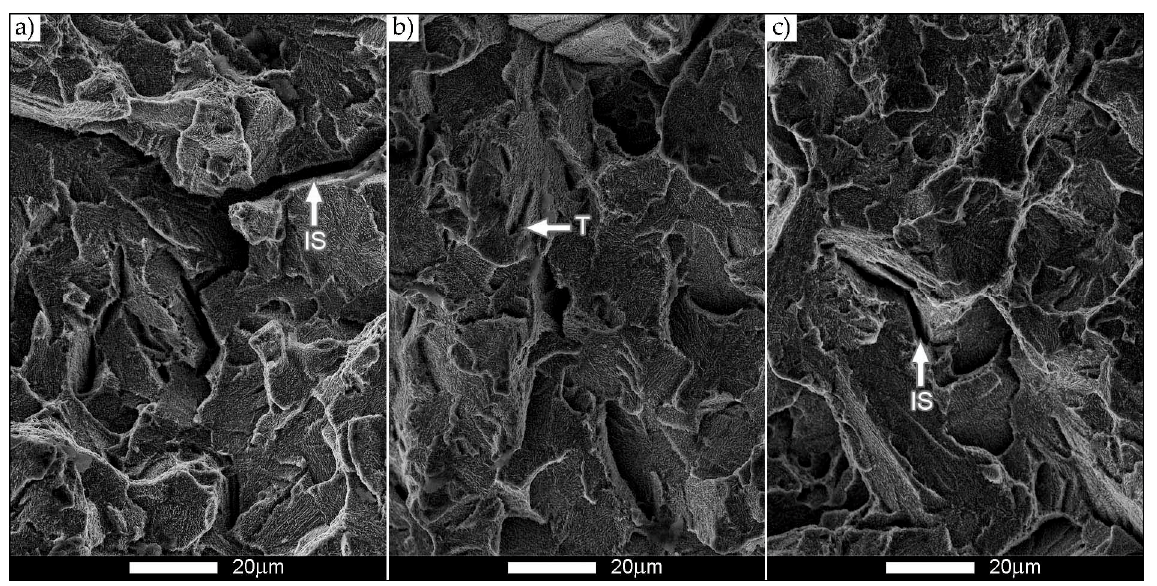
Figure 18. Images of the Hardox Extreme steel fracture surface in normalized state shown in Figure 10: transverse orientation (+20 °C). ( a ) The area marked with the A1 frame. ( b ) The area marked with the B1 frame. ( c ) The area marked with the C1 frame. IS—intergranular steps, T—tongues. SEM, non-etched state.